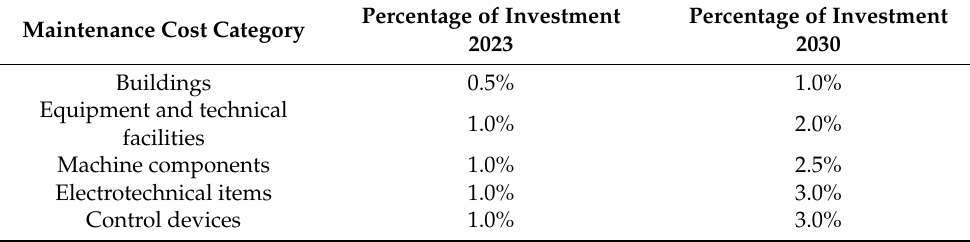
Table 2. Maintenance costs as percentage of